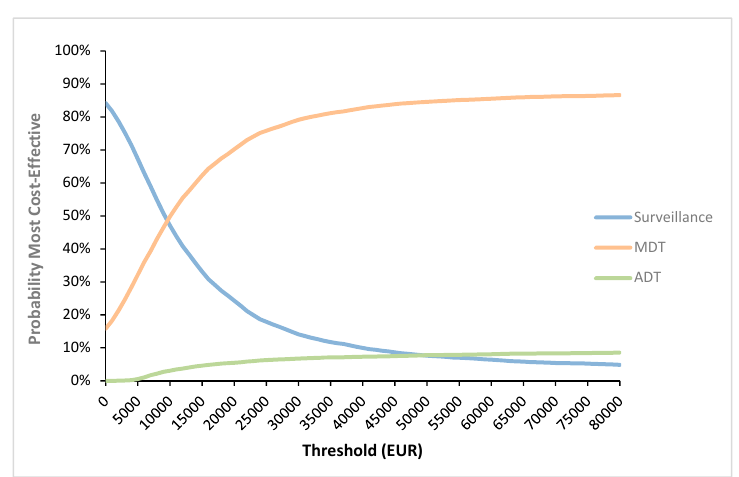
Figure 2. Graphic representation of 10,000 simulations of the cost-utility analysis of MDT versus surveillance. Every dot represents a simulation of the cost-utility analysis. The red line represents the WTP threshold. The red dot represents the mean ICER. Differences are calculated as MDT minus surveillance/ADT. ( A ) Cost-utility plane of MDT versus surveillance. ( B ) Cost-utility plane of MDT versus ADT. Please remark the different scales in Figure 1A,B. Abbreviations; MDT: Metastasis-directed therapy; QALY: Quality adjusted life years; WTP: Willingness-to-pay. Cancers 2020 , 12 , x